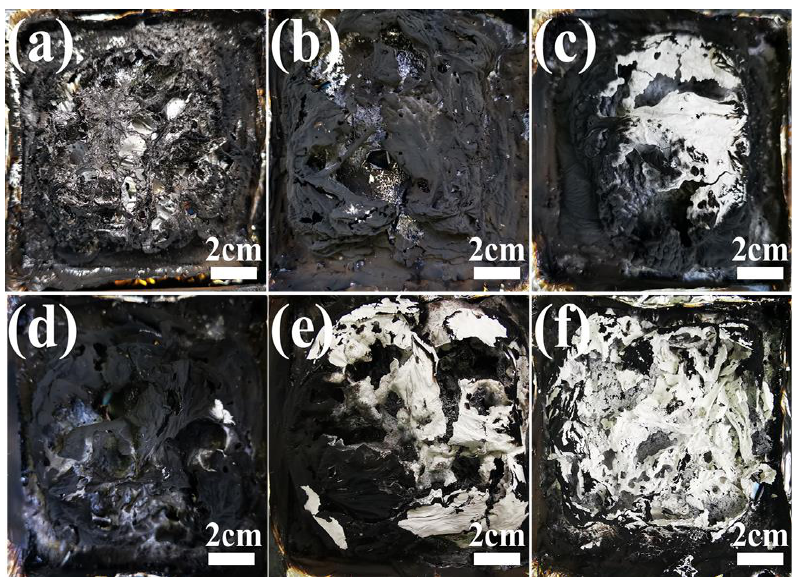
Figure 12. Digital images of EP char residue ( a ), EP/2.5MBR@LDHP-APES ( b ), EP/5.0 MBR@LDHP- APES ( c ), EP/7.5MBR@LDHP-APES ( d ), EP/7.5MBR@LDHP ( e ) and EP/7.5MBR ( f ). 379 The EP, EP/7.5MBR@LDHP-APES, 380 EP/7.5MBR@LDHP, and EP/7.5MBR samples after the burning test were also observed by 381